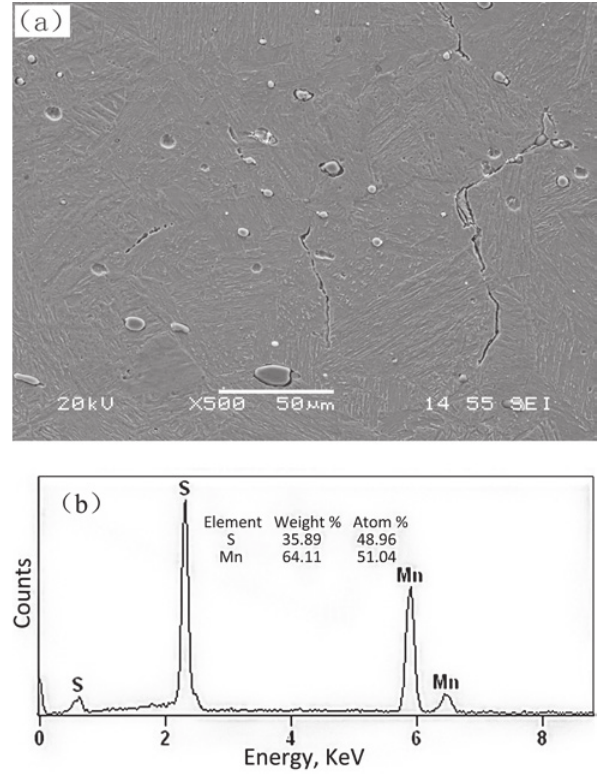
Fig. 9: Typical longitudinal microstructures of quenched fractures at 1000 °C for steel 4: (a) microstructure near fracture; (b) EDS of sulfide